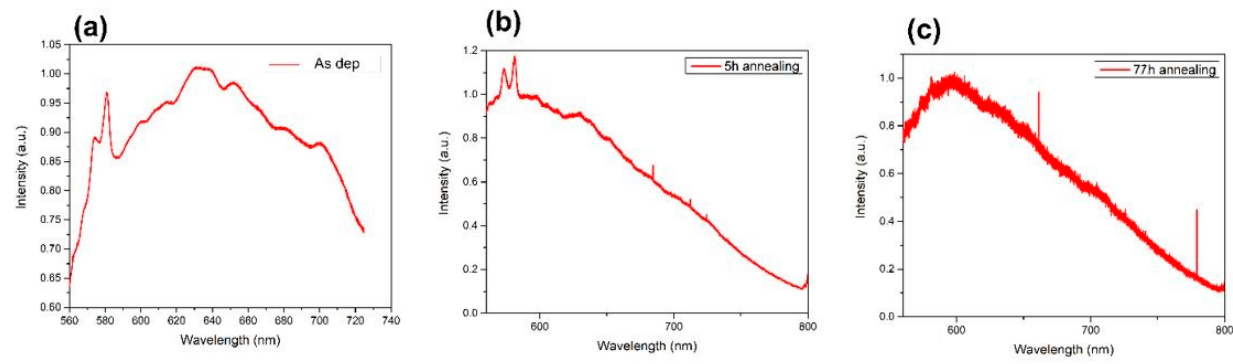
Figure 5. PL spectra for the as-deposited ( a ), the 425 °C 5 h annealed ( b ), and ( c ) the 425 °C 77 h annealed sample.